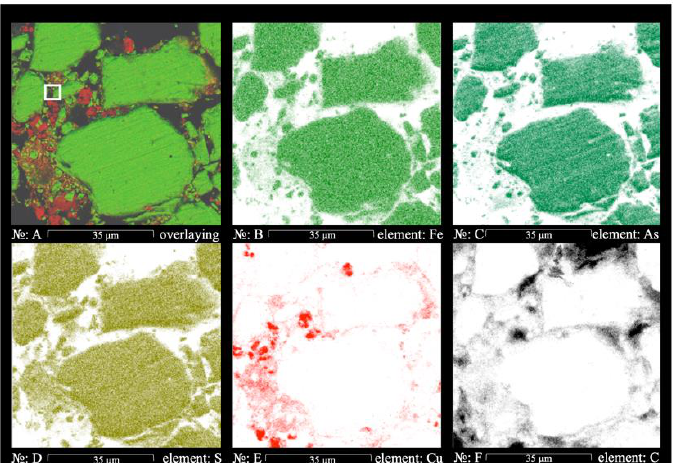
Figure 11. EDS mapping of FeAsS particles after hydrothermal treatment at 523 K, 100 rpm, 0.1 mol/L of H 2 SO 4 , 0.16 mol/L of Cu, 10–29 µ m in cross-sectional view: overlaying ( A ); As distribution ( B ); Fe distribution ( C ); S distribution ( D ); Cu distribution ( E ); C distribution ( F ).